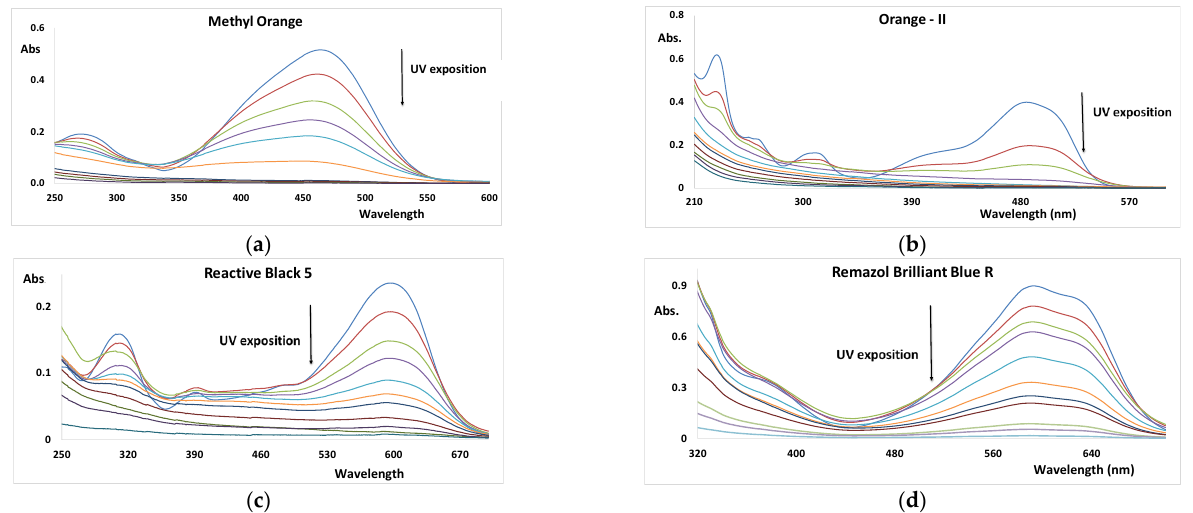
Figure 3. UV–Vis spectra of dyes as function of the UV/H 2 O 2 exposition (pH = 7, and reaction time = 30 min). ( a ) Methyl orange; ( b ) Orange-II; ( c ) Reactive Black 5; and ( d ) Remazol Brilliant Blue R. Table 2. Apparent first-order rate constant, percentage of the rate constant when the catalyst is pre- sent, and percentage of dye discoloration of the UV + H 2 O 2 AOP of dyes (the standard deviations of at least three independent repetitions are shown). In parentheses, the reaction time necessary to achieve the percentage of dye removal is shown. The fitting of the integrated first-order kinetics resulted in R 2 > 0.98.